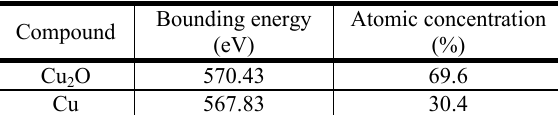
Table 2. Type of copper-compounds and their distribution on the worn disc surface tested with 0.5 wt%CuO